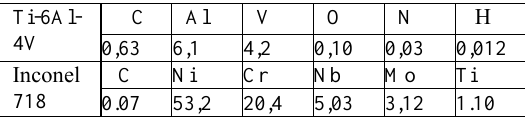
Table 1. Chemical compositions of alloys (wt.%) Ti-6Al-